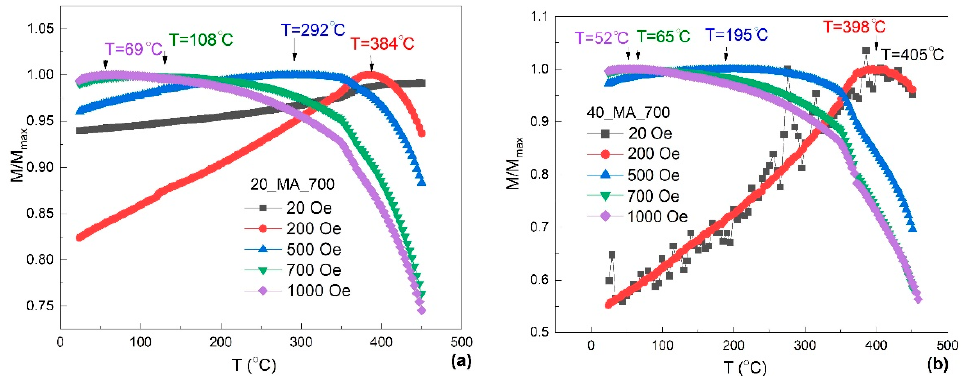
Figure 3. Normalized magnetization curves versus temperature for the samples ( a ) 20-MA-700 and ( b ) 40_MA_700 , illustrating the temperatures of the magnetization maxima.